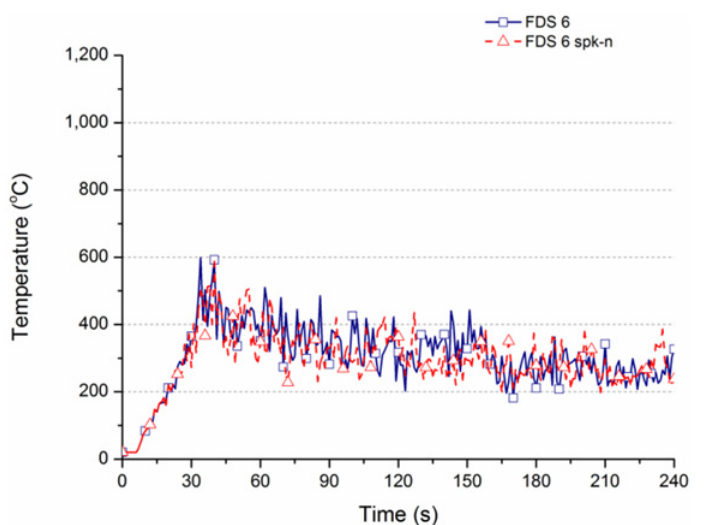
Fig 9. Temperature variation for different settings of FDS